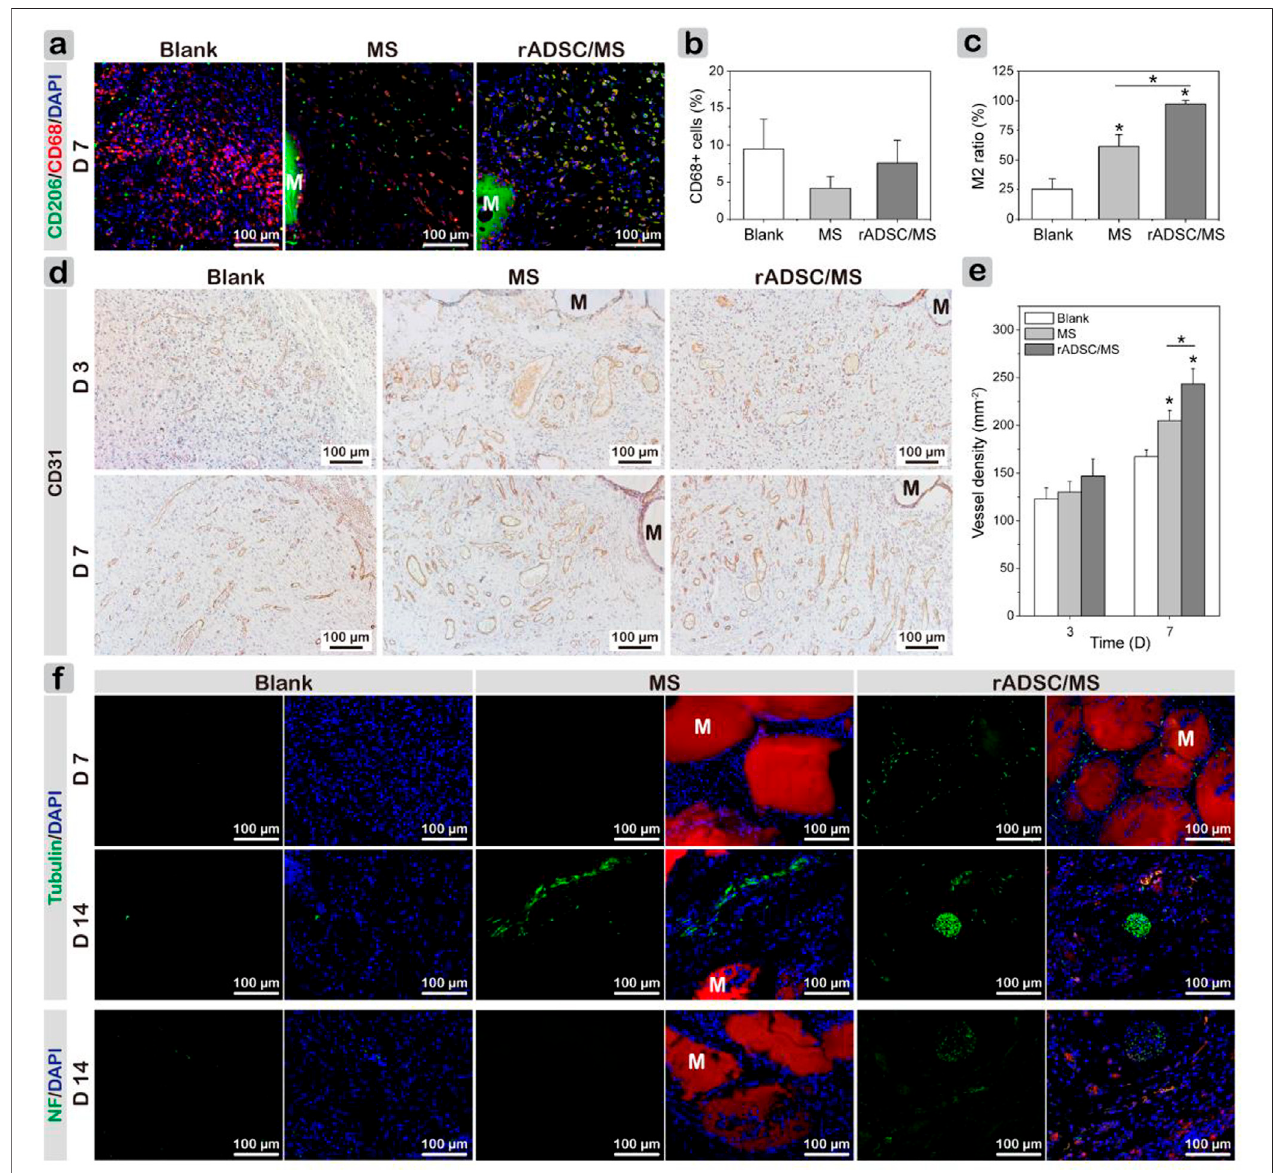
FIGURE 6 | Investigating mechanism of MS and rADSC/MS on promoting diabetic wound healing by evaluating macrophage polarization, angiogenesis, and neurogenesis during wound healing. (A) Representative CLSM images for all groups on day 7 showing increased presence of M2 macrophages around microspheres, as evidenced by co-staining of CD68 and CD206. CD68 antibody was conjugated with Alexa Fluor 647 (650/668 nm), and CD206 antibody was conjugated with Alexa Fluor 568 (578/603 nm). (B) Percentage of CD68 + cells; (C) M2 macrophage ratio of CD206 + CD68 + cells to CD68 + cells. (D) Representative CD31 immunohistochemical staining images of wound sections on days 3 and 7 and (E) corresponding quantitative results of vessel density. (F) Immuno fl uorescence images of sections revealing distribution of newly regenerated neurons (tubulin) and axon (Neuro fi lament-L) in all groups on days 7 and 14, respectively. Tubulin and Neuro fi lament-L antibodies were conjugated with Alexa Fluor 488 (495/518 nm). “ M ” represents gelatin microspheres. Fluorescence intensity was calculated using ImageJ. Data = mean ± SD, n = 3, * p < 0.05 when compared with blank or MS group.